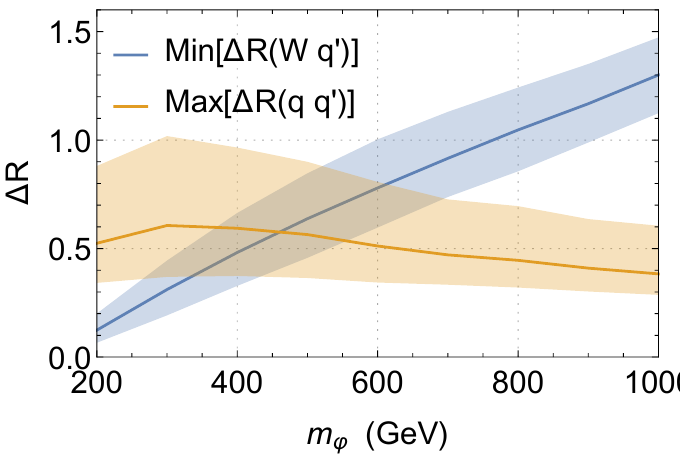
Figure 4. Parton-level separations within a boosted diboson jet produced from the decay of a 3 TeV parent resonance. Orange: in each event, the larger of the two angular separations between two quarks from a W q (cid:22) q decay. Blue: in each event, the smallest angle between a W boson and ! a quark coming from the other W boson. In each case, the solid line represents the mean over the event sample, while the shaded band represents the range between the 16th and 84th percentile (one